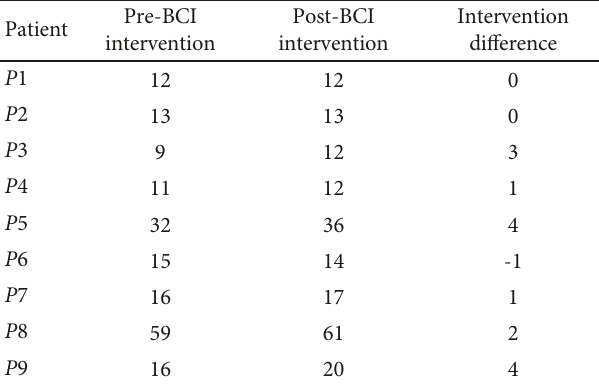
Table 2: FMA-UE scores for 9 patients. Score ranges from 0 to 66; higher score ’ s values imply lesser upper limb motor